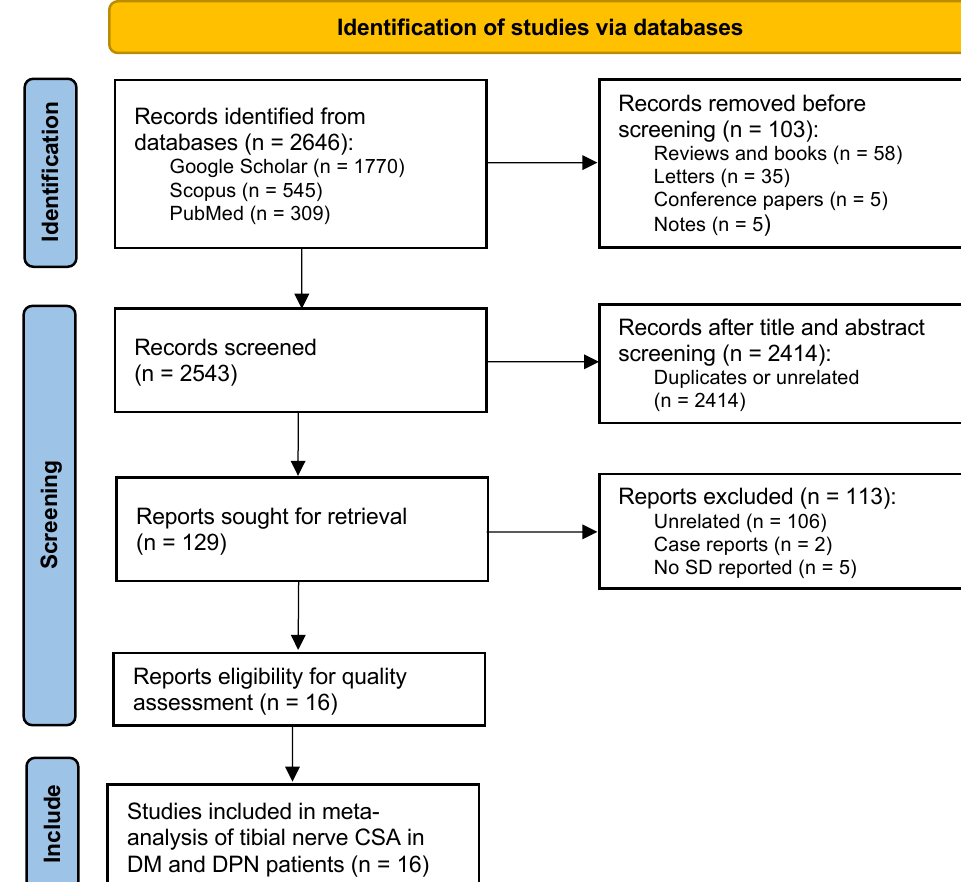
Figure 1. PRISMA flowchart summarizing the protocol of the present